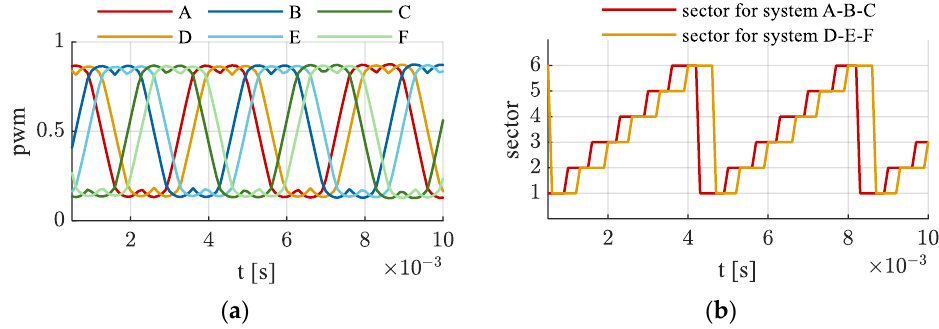
Figure 7. Startup transient of the six-phase operation: ( a ) rotor speed; ( b ) current in d–q subsystem.